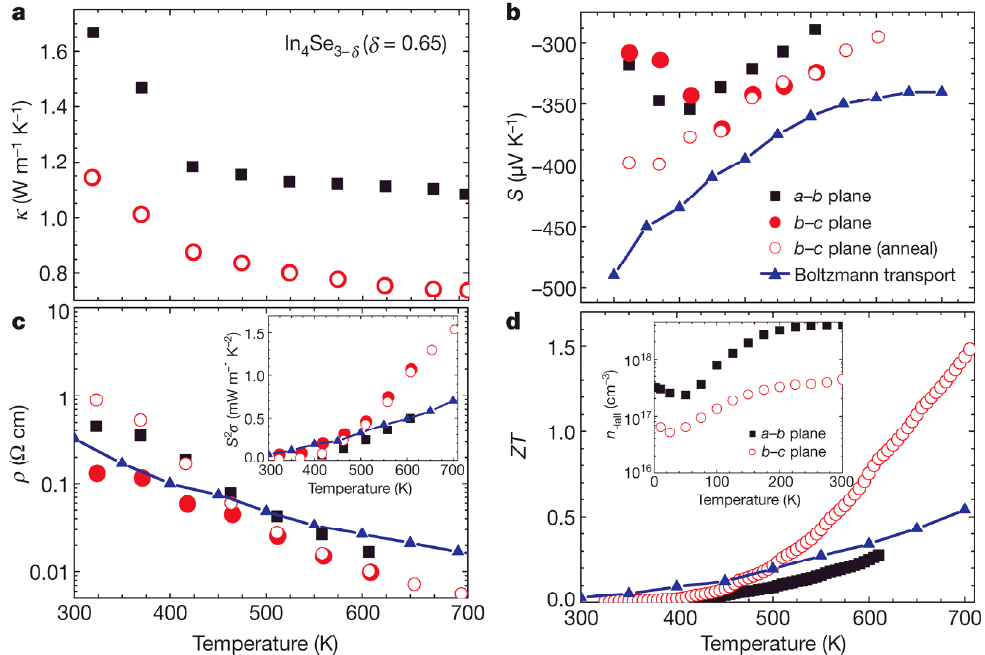
Figure 6. Thermoelectric properties of bulk crystalline In 4 Se 3 −δ ( δ = 0.65); ( a ) thermal conductivity, ( b ) Seebeck coefficient, ( c ) electrical resistivity (inset shows the power factor), and ( d ) Dimensionless figure-of-merit (inset shows the Hall carrier concentration). Reproduced with permission from Nature publishing Group, 2009